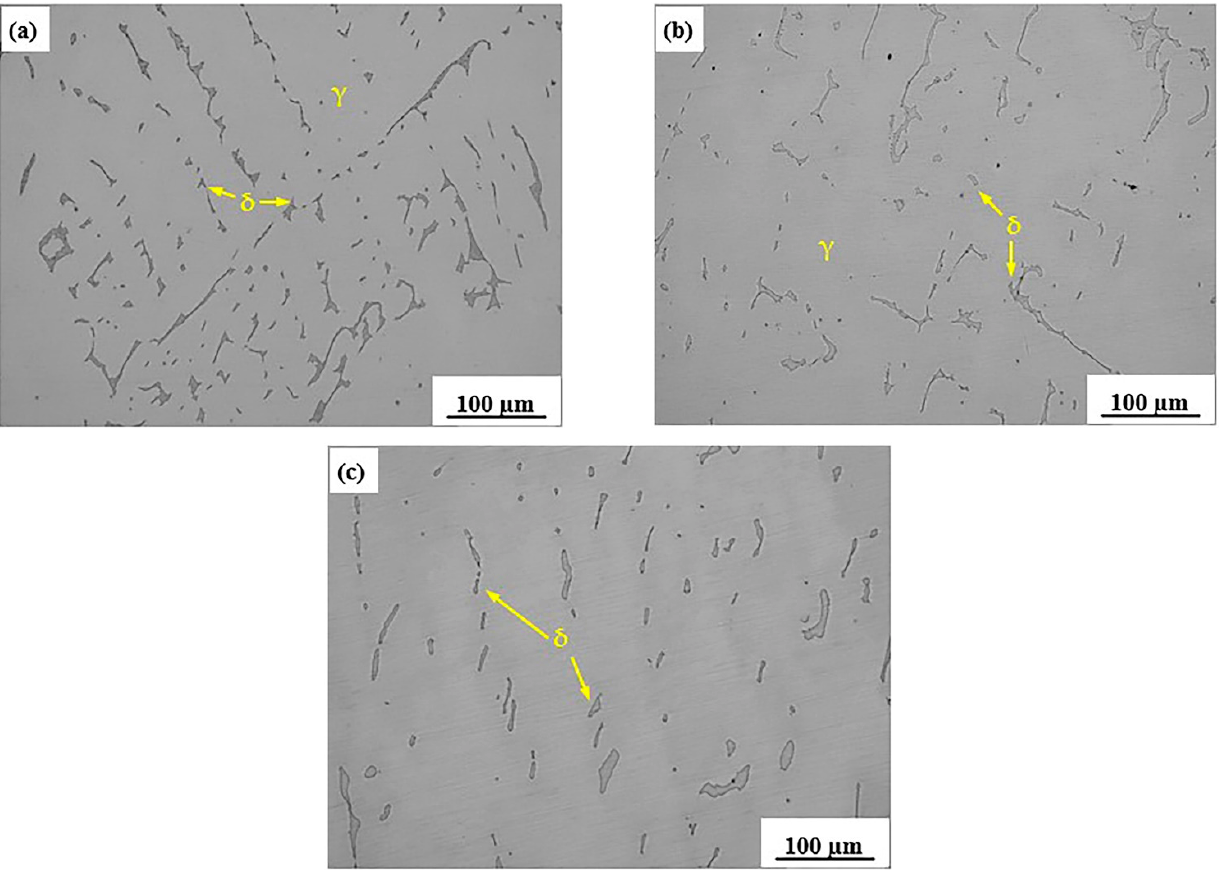
Figure 7. Metallographic diagram of 304-Cu stainless steel at 200 times magnification: ( a ) 800 °C, ( b ) 900 °C, ( c ) 1100 °C.